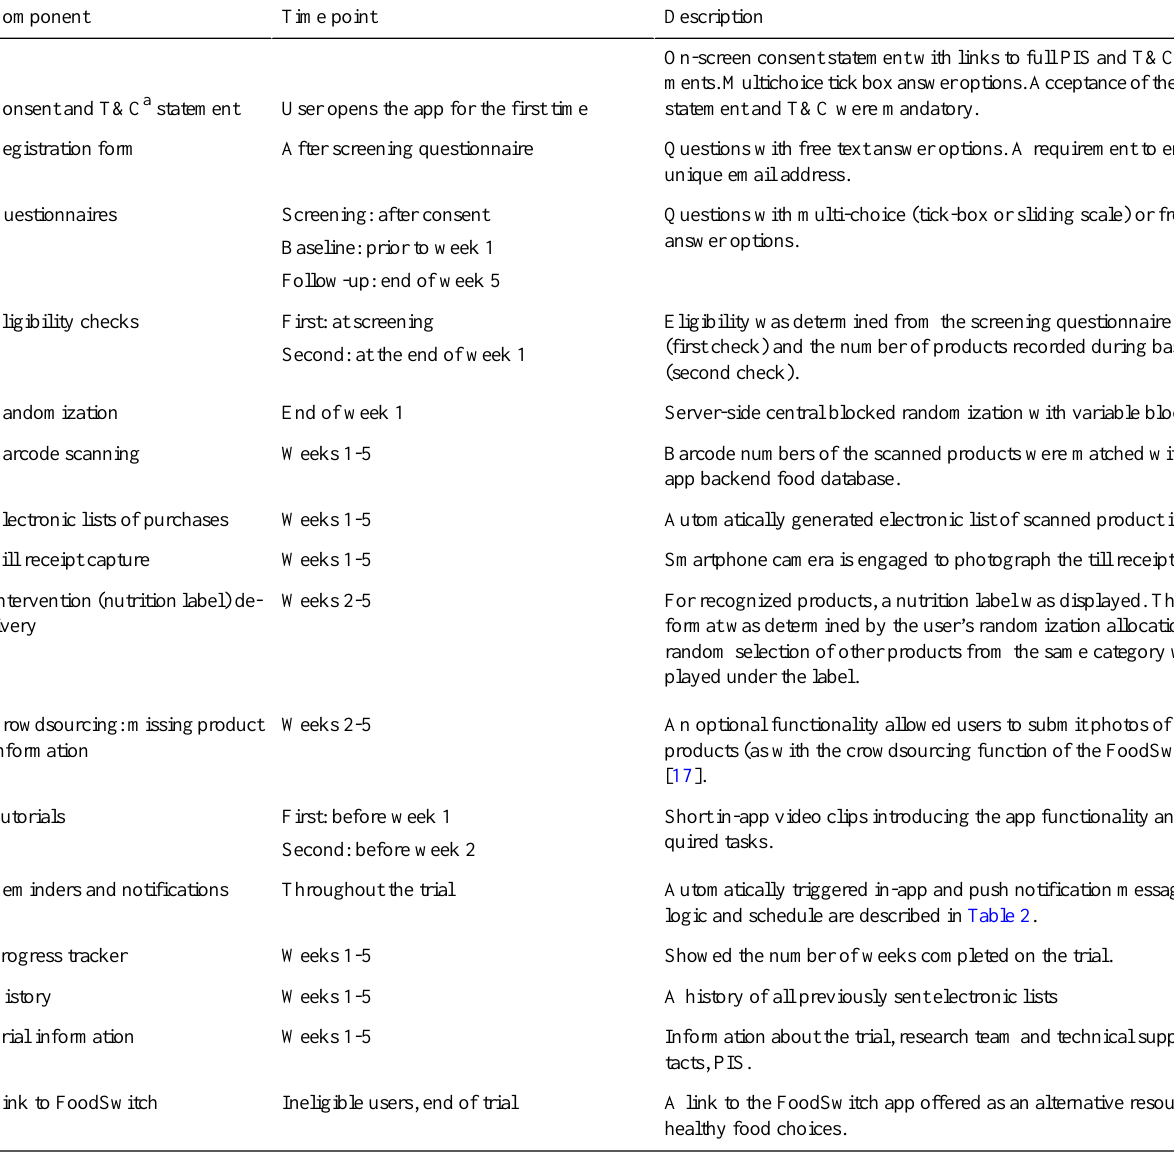
Table 1. Main functions of the Food Label Trial app.